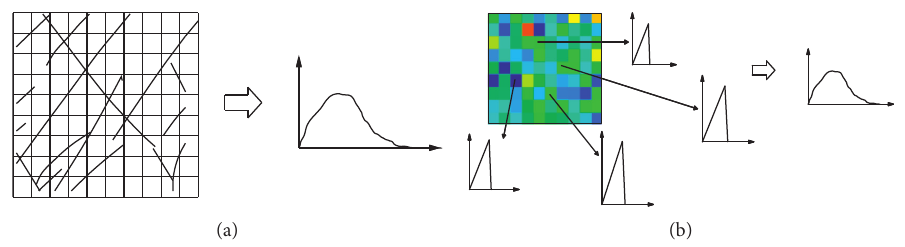
Figure 1: Heterogeneous distribution of mechanical properties from linear mesoscopic to nonlinear macroscopic mode. (a) Heterogeneous rock with mesodamage. (b) RFPA model of heterogeneous rock.